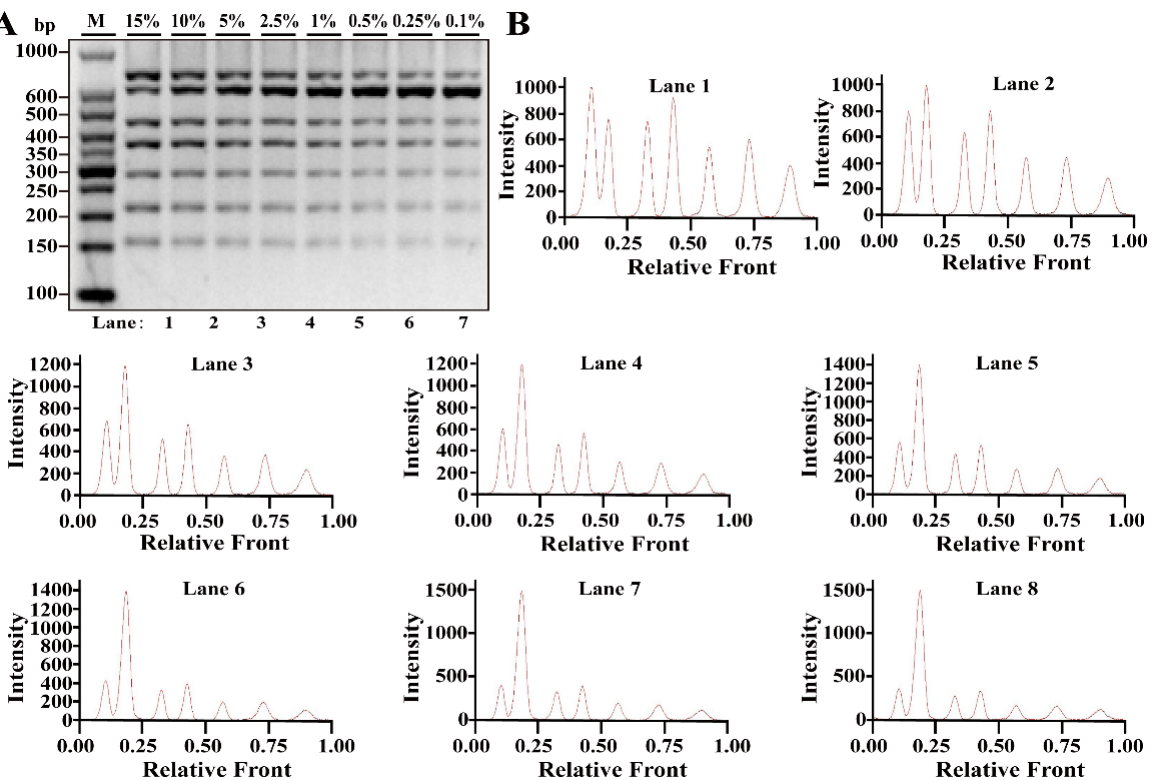
Figure 3. Validation of sensitivity of multiplex PCR assay in meat model mixtures. ( A ) Gel image of PCR fragments amplified by multiplex PCR using DNA from model mixtures of camel, dog, pig, chicken, sheep and duck added to cattle at 15%, 10%, 5%, 2.5%, 1%, 0.5%, 0.25% and 0.1% of total weight, respectively. ( B ) The corresponding electropherograms represent camel, cattle, dog, pig, chicken, sheep and duck in each lane. Lanes 1–8 are presented with labels (15%, 10%, 5%, 2.5%, 1%, 0.5%, 0.25% and 0.1%) in ( A ). The value of number at the horizontal line means the relative position of peaks distant from the top of agarose gel. The value of number at the vertical line means the fluorescent intensity of DNA-bound dyes (4 S GelRed Nucleic Acid Stain). Lane M is ladder DNA.